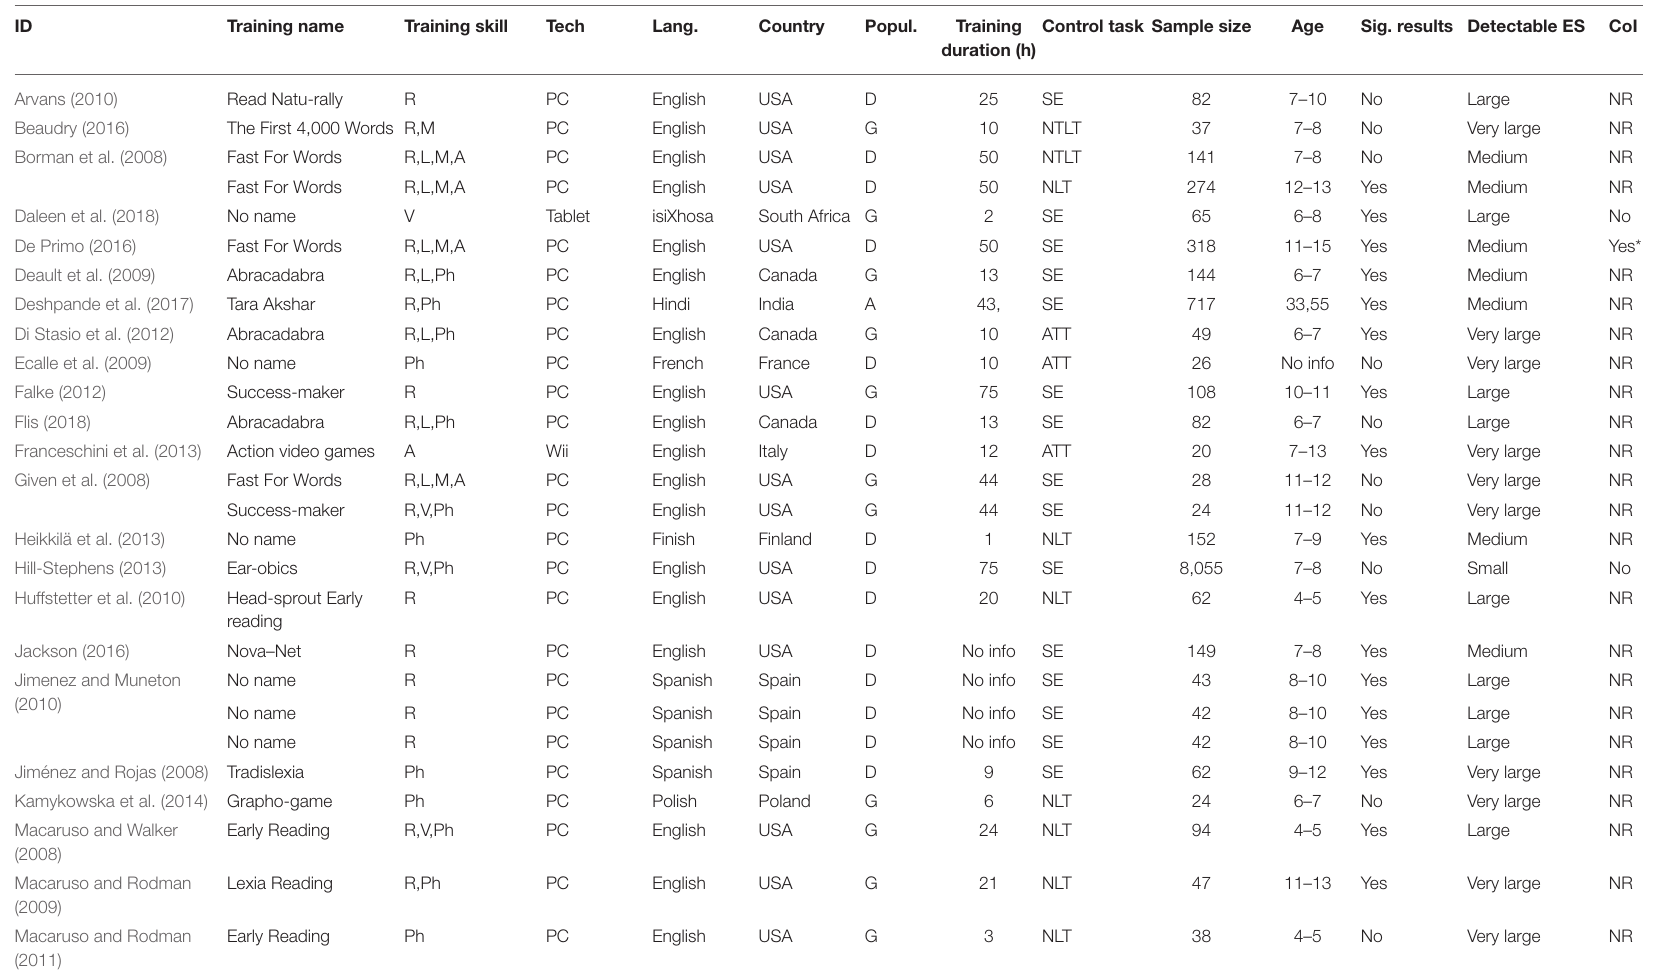
TABLE 1 | Articles included in the systematic review, and main characteristics of the computerized training used in each of